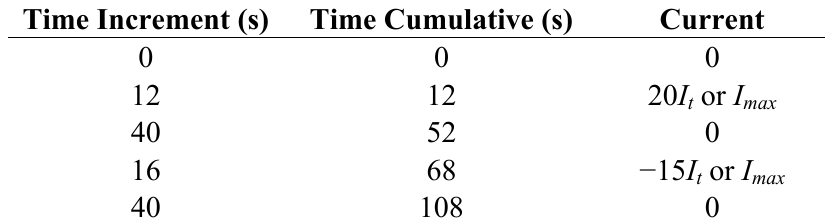
Table 4. Test sequence energy efficiency according to ISO/CD 12405-1/2 [ 28 ]